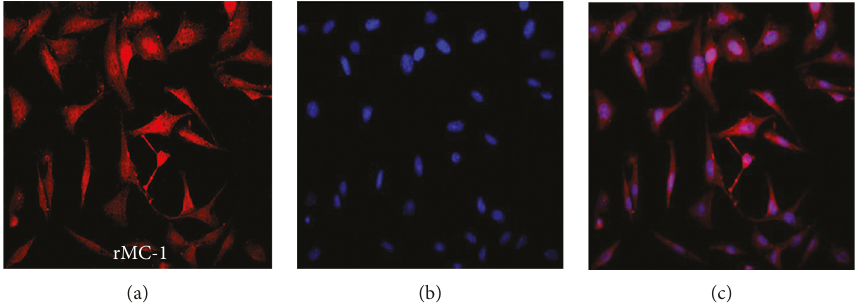
Figure 1: Rat M¨uller cells were stained with M¨uller cell-specific marker GFAP. (a) GFAP. (b) DAPI. (c) Merge.